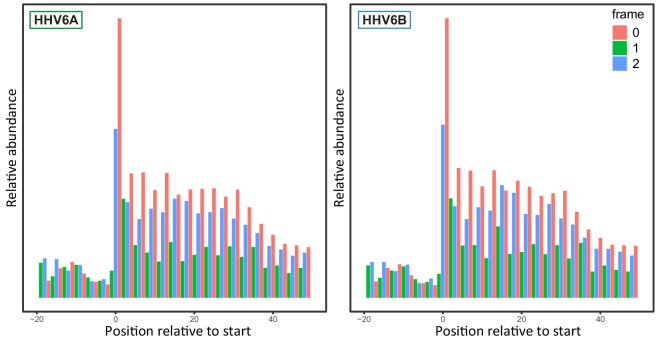
Reading-frame distribution of Ribo-seq reads.Aggregated normalized reads from HHV-6A and HHV-6B CHX treated Ribo-seq libraries around start codons of human protein coding genes. Colors signify the translation reading frame to which the p-site of read was mapped.